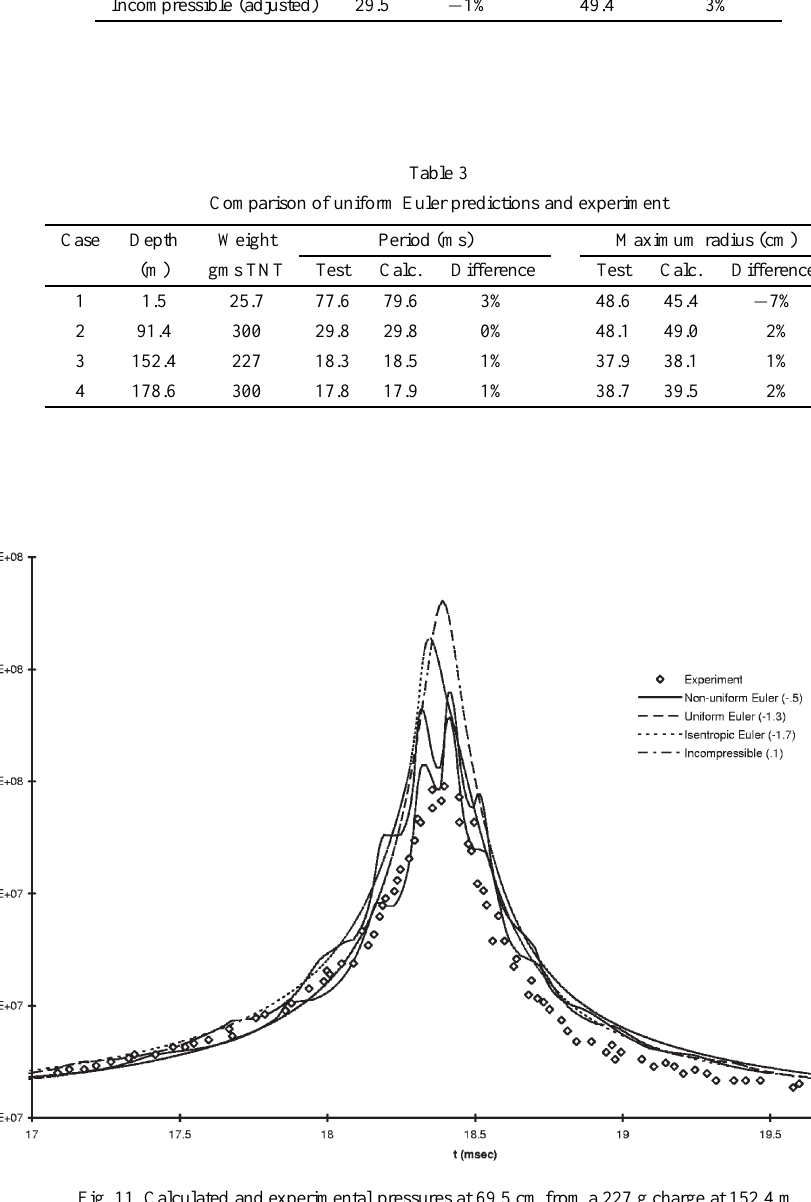
Fig. 11. Calculated and experimental pressures at 69.5 cm from a 227 g charge at 152.4